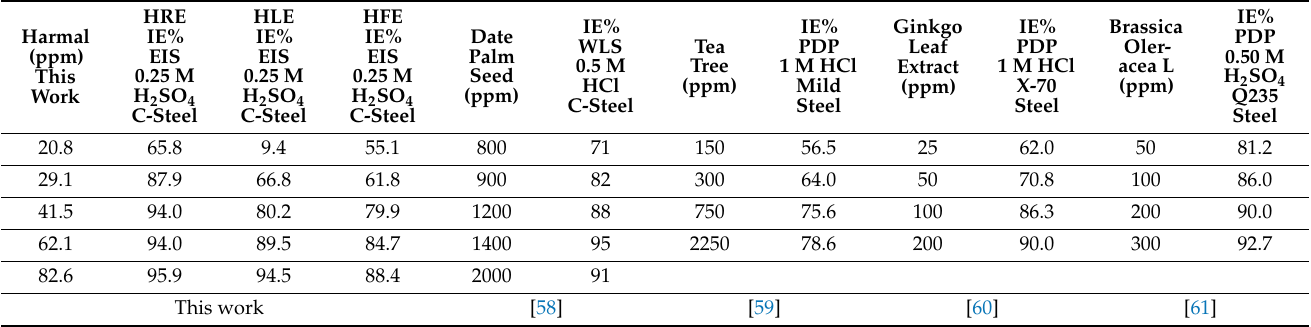
Table 11. Percent inhibition efficiency (IE%) toward steel corrosion in sulfuric acid by Harmal roots, leaves, and flower extracts compared with other reported systems at various concentrations (ppm)